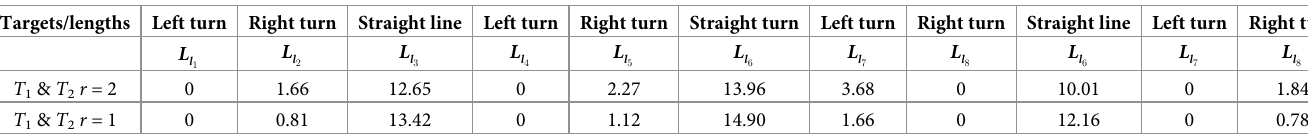
Table 2. Multiple targets touring—Numerical performance of model